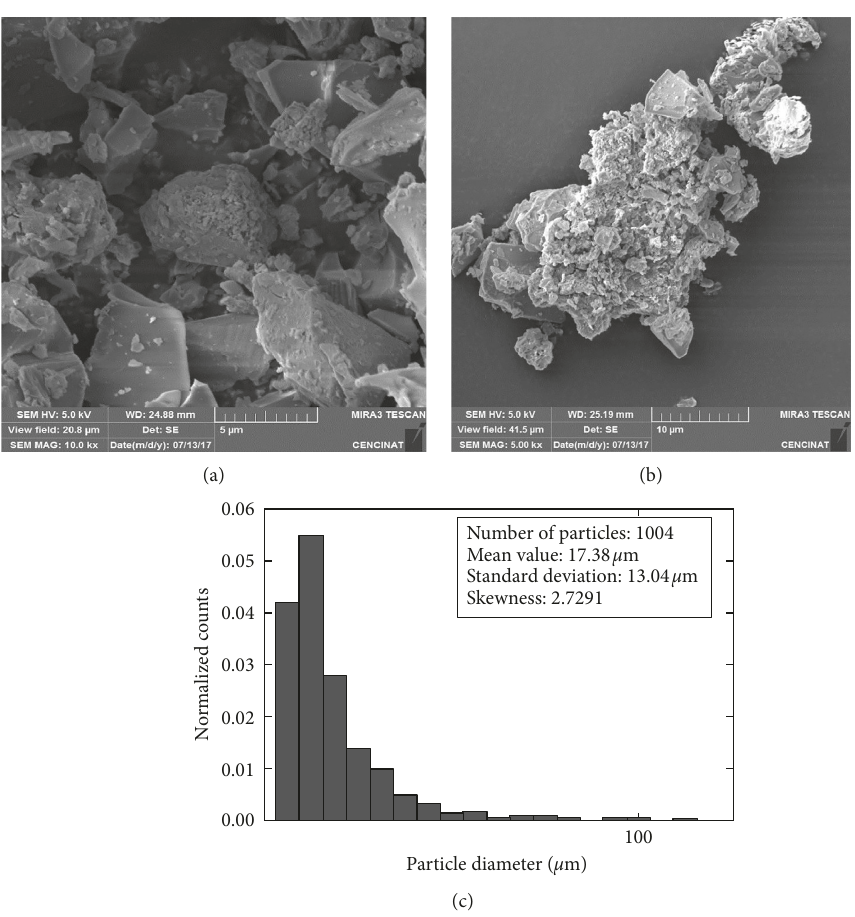
Figure 1: Representative SEM image of Pichincha’s volcanic ash: (a) at 10000x magnifications; (b) at 5000 magnifications. The images illustrate angular- and round-shaped particles. (c) Granulometry of fine-grained volcanic ash of the 5th of October 1999 eruption of the PVC, using the MIRA3 SEM software based on 1004 particles. Table 2: Chemical composition expressed as mass percent of major elements of 100 ash particles from the ash samples of the 5th of October 1999 eruption of the PVC (see Table S1 for details). Element Na Mean